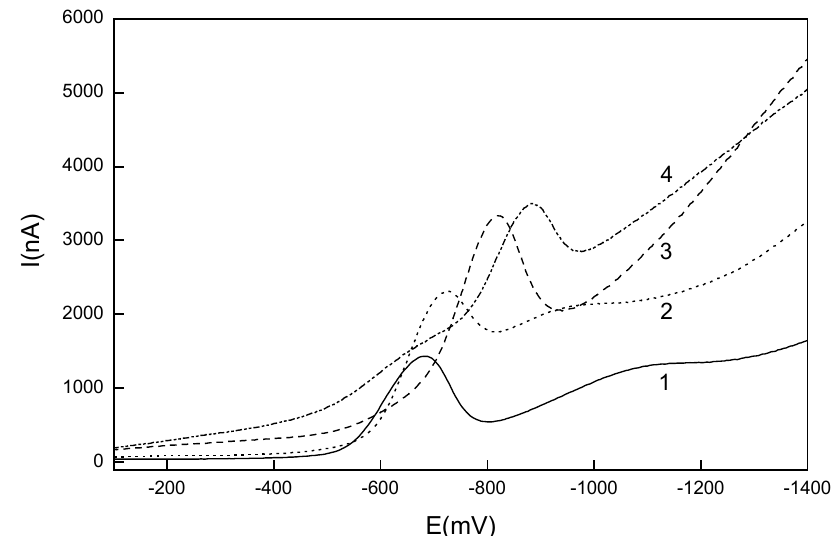
Figure 6. Selected DP voltammograms of 1-NP (c=1.10 -4 mol.L -1 ) at GCPE in mixture of a BR buffer : MeOH (1:9 v/v) mixture with buffer pH 3 (1) , 5 (2), 8 (3) and 12